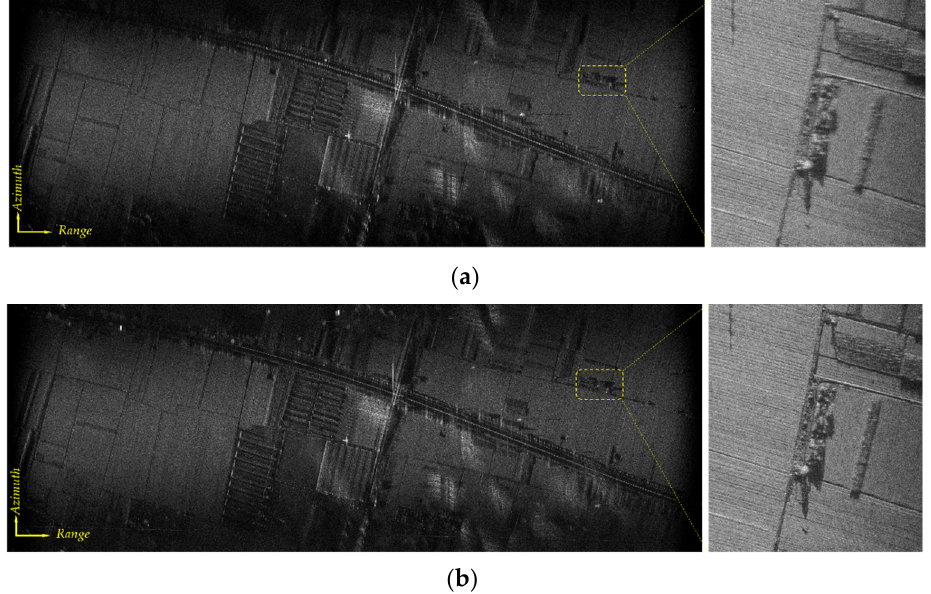
Figure 12. Real data experiment results of the high-squint airborne Ka-band CF-SAR. ( a ) Result pro- cessed by the conventional two-step method. ( b ) Result processed by Ren et al. [8].